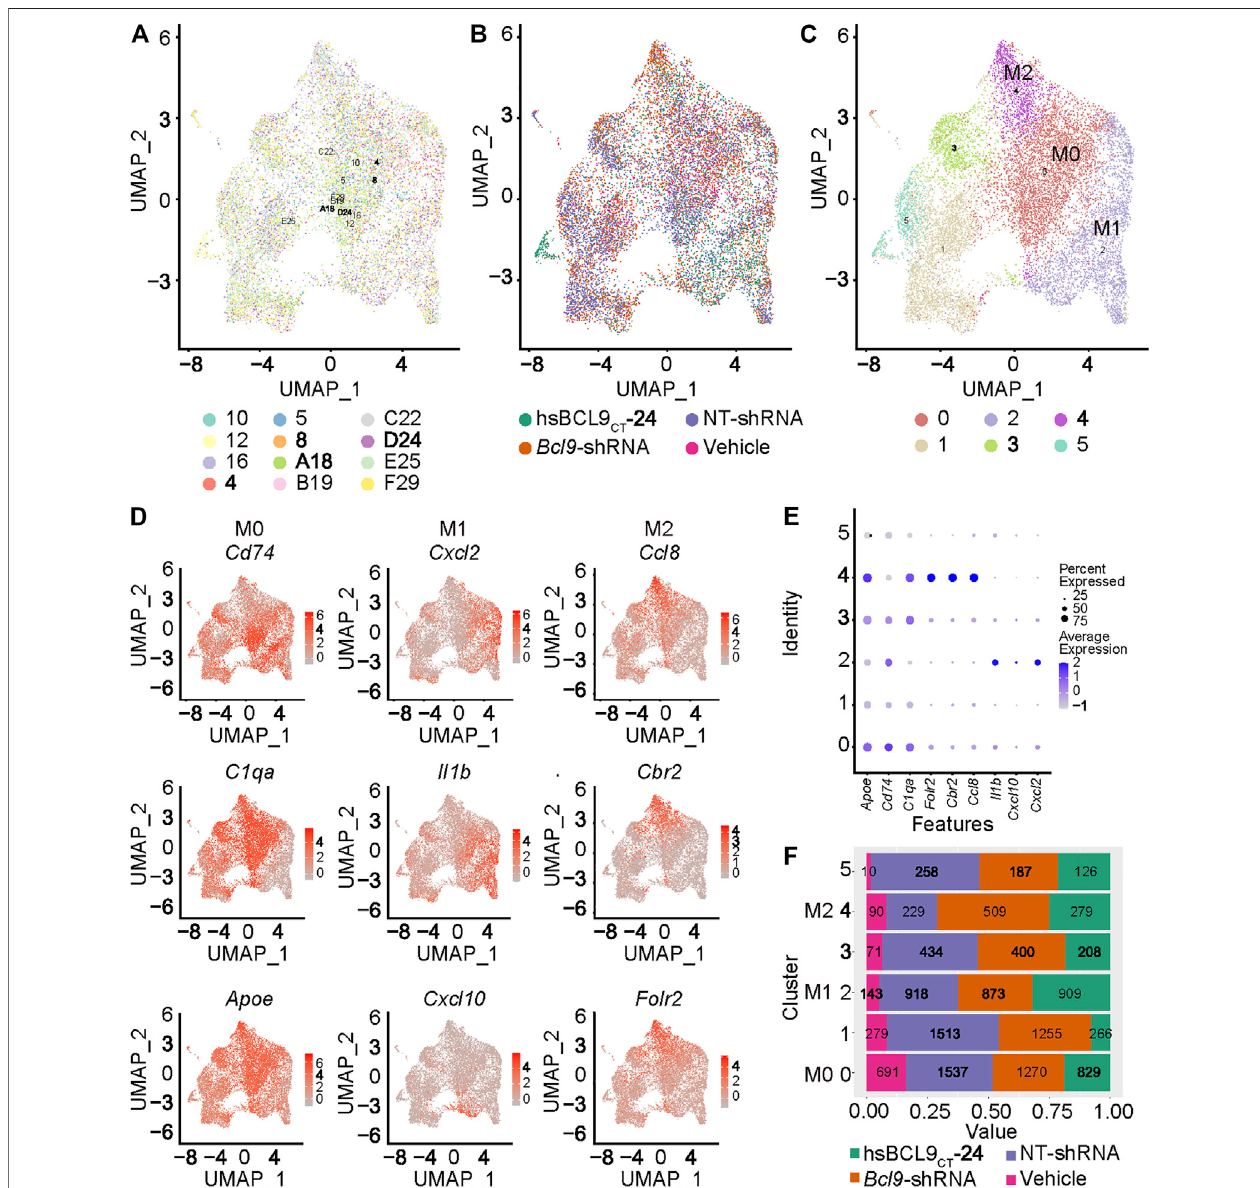
FIGURE3| PopulationofM0,M1andM2intheTAMofmouseCT26tumor.Re-cluster(Step2re-clustering)analysisofTAM(Thepopulationcircledinred dashin Figure 2 ). (A) UMAP mapping and clusters and samples. (B) UMAP mapping and groups (vehicle, hsBCL9 CT -24, NT-shRNA, Bcl9 -shRNA). (C) UMAP mapping and clusters. (D) UMAPmappingandM0,M1andM2markerGeneexpressionlevel. (E) BubblechartofTAMclusterswithM0,M1andM2markerGeneexpressionlevel. (F) Barchart of cell proportions of different groups in TAM clusters, the number is the actual number of cells.